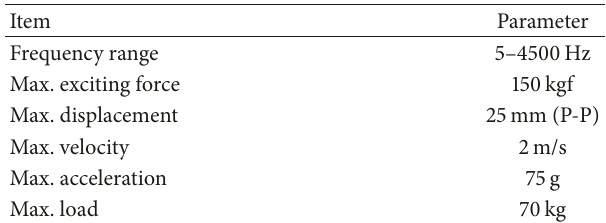
Table 1: The technical parameters of STI